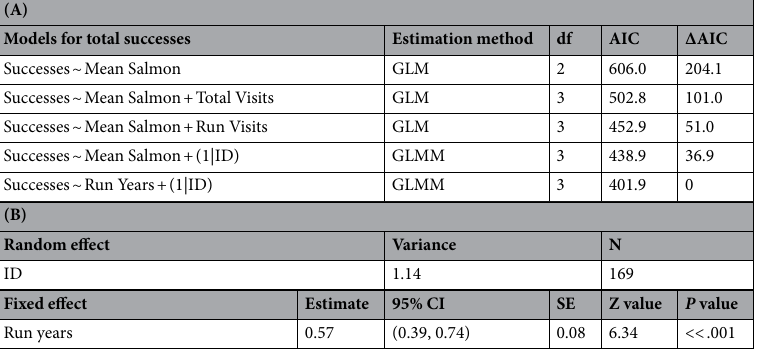
Table 1. (A) Model results predicting the total number of successful foraging attempts recorded by individual harbor seals relative to number of run visits, number of total visits, and individual ID. The change in AIC value is the difference between the tested model and the model of best fit (as determined by the lowest AIC value). (B) Generalized Linear Mixed-Effects Model (GLMM) output for the final, most parsimonious model describing the total number of successful attempts recorded by an individual harbor seal. CIs represent the 95% confidence interval for the estimate of each parameter in the model. Note that a P value cannot be reliably calculated for random effects in mixed models and thus has been omitted from the